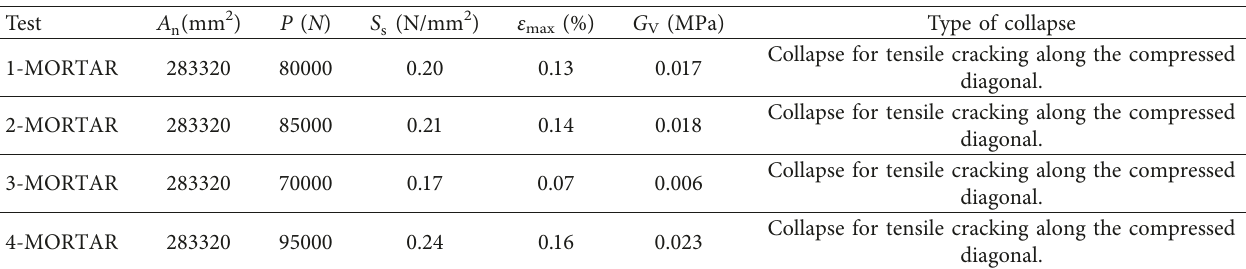
Figure 18: Details of the diagonal compression test (a) and relative test setup (b). Table 8: Mean shear strength in case of diagonal compression test for masonry with mortar.